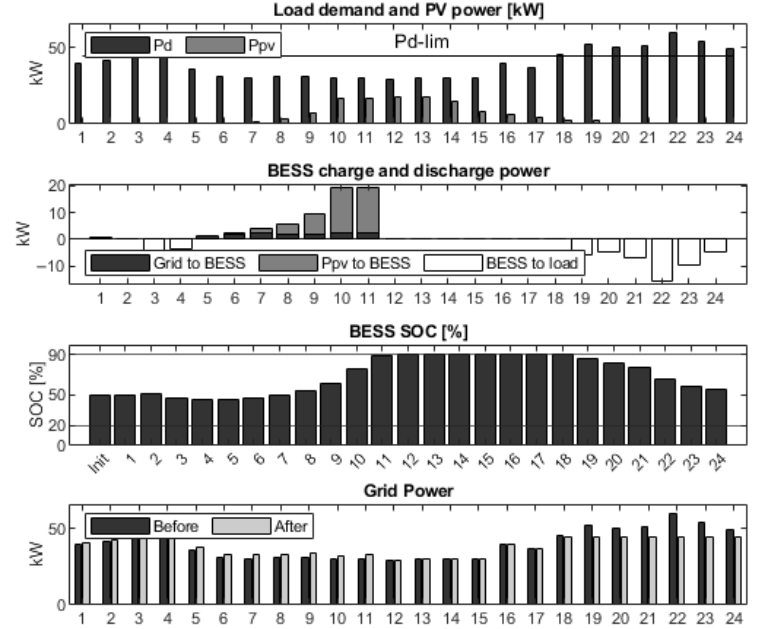
Figure 8. Load demand and PV profile, charge and discharge behavior of the BESS as well as SOC during a day, and a power profile comparison before and after peak shaving operation (the 19th of January).